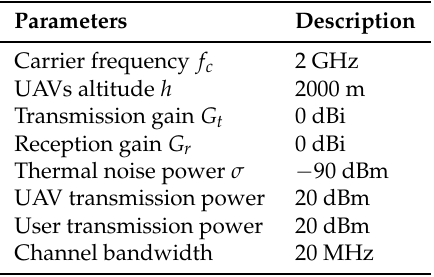
Table 1. Simulation